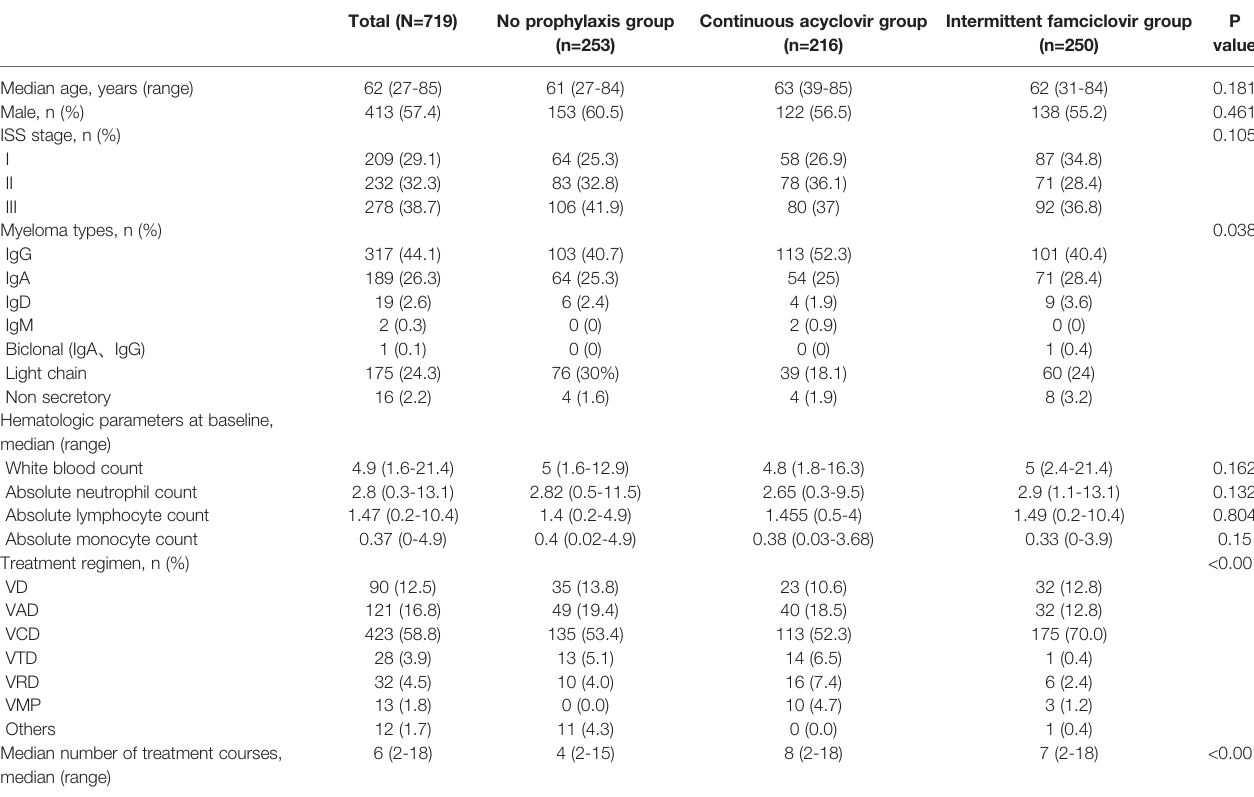
TABLE 1 | The demographic and baseline clinical